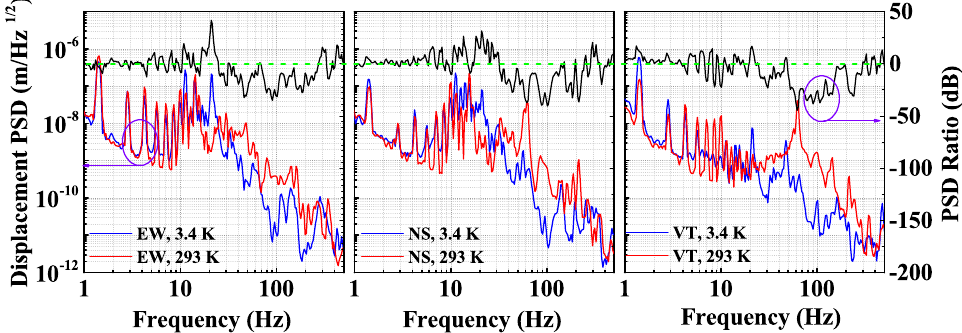
Figure 2. The vibration PSD of the cryogenic plate when the cryocooler has just been turned on at 293 K (red curves) and when it is in stable operation at 3.4 K (blue curves). The upper black curve is the ratio of vibration PSD from 293 to 3.4 K, green dashed line for a 0 dB PSD ratio guide line. Violet circles and arrows are visual guides for the vertical